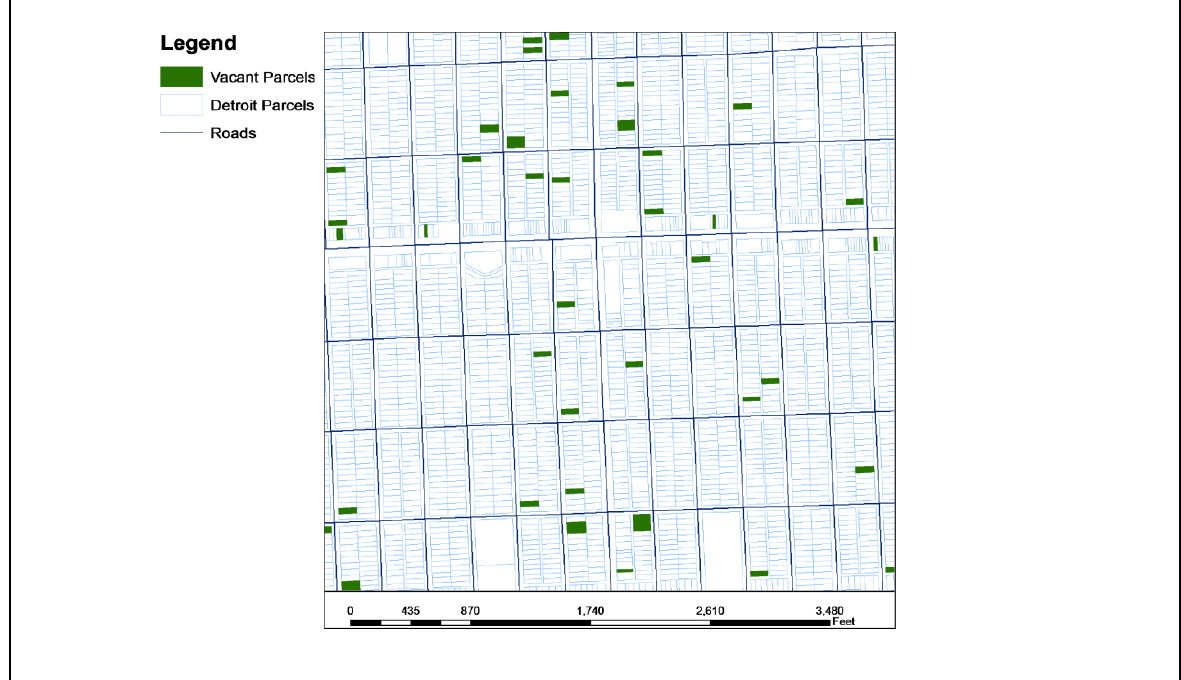
Figure 4. Example of Vacancy Distribution in a High-Vacancy Neighborhood. These neighborhood blocks, which are located in zip code 48215, correspond to Square 2 in Figure 2. Most of the larger shaded areas comprise multiple